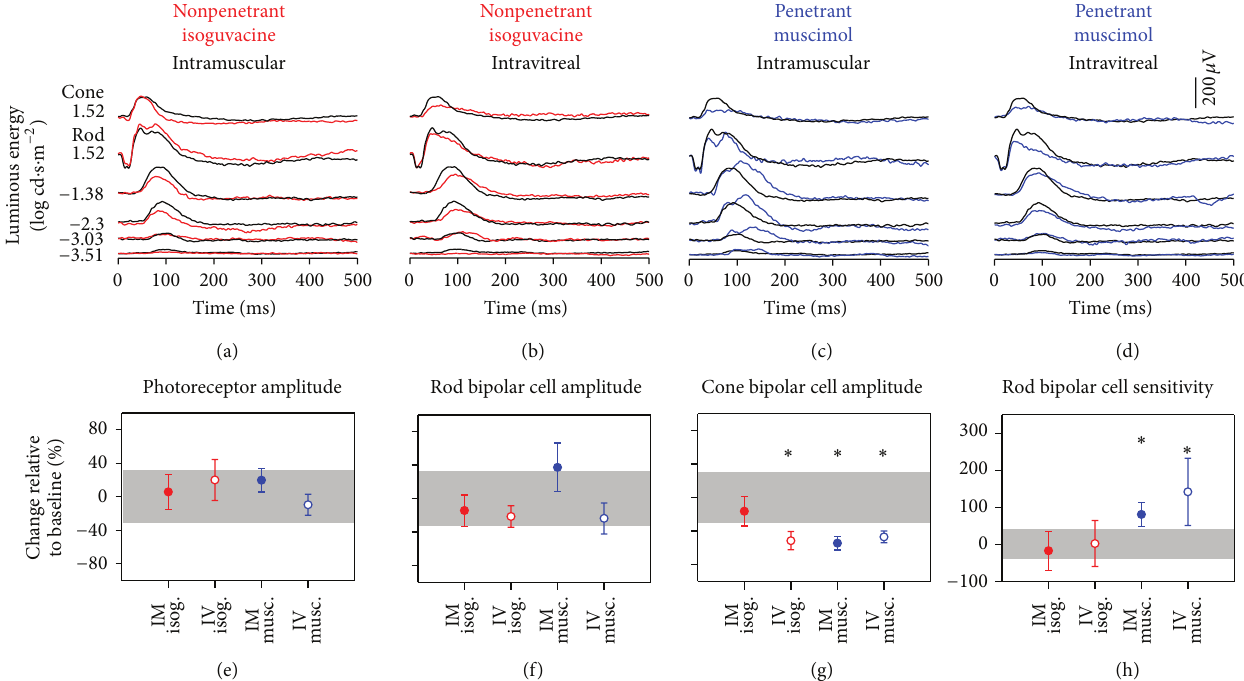
Figure 1: Retinal electrophysiology following conscious isoguvacine/muscimol dosing. ERG responses in conscious animals ((a)–(d), 𝑛 = 7 for each drug group) at baseline (black lines, average of vehicle injections in both conscious groups) compared to (a) intramuscular and (b) intravitreal injection of isoguvacine (red) and (c) intramuscular and (d) intravitreal injection of muscimol (blue). (e)–(h) summarise ERG parameters (average ± SEM) following isoguvacine or muscimol injections via the different delivery routes (see method for details). Grey areas indicate 95% CI of the particular ERG parameter in all conscious baseline recordings. ∗ 𝑝 < 0.05